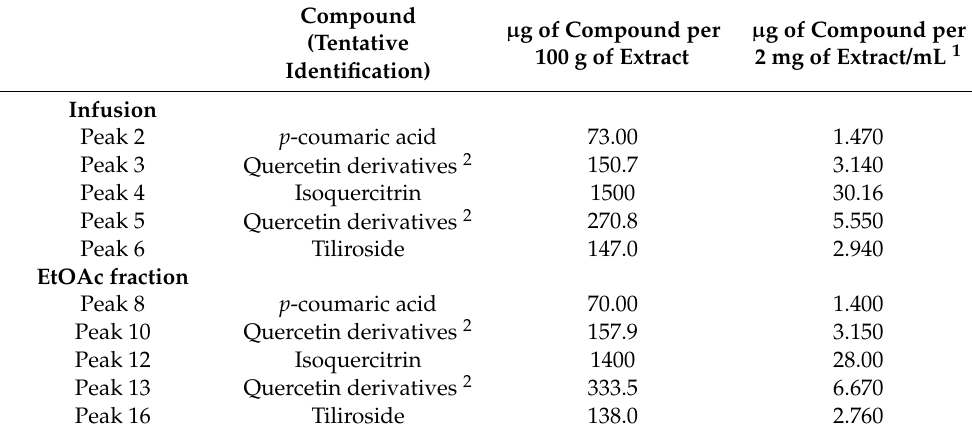
Table 1. Quantification of p -coumaric acid, quercetin derivatives and tiliroside in the infusion and the EtOAc fraction of A. eupatoria by HPLC-PDA and the respective concentrations in organ bath experiments.